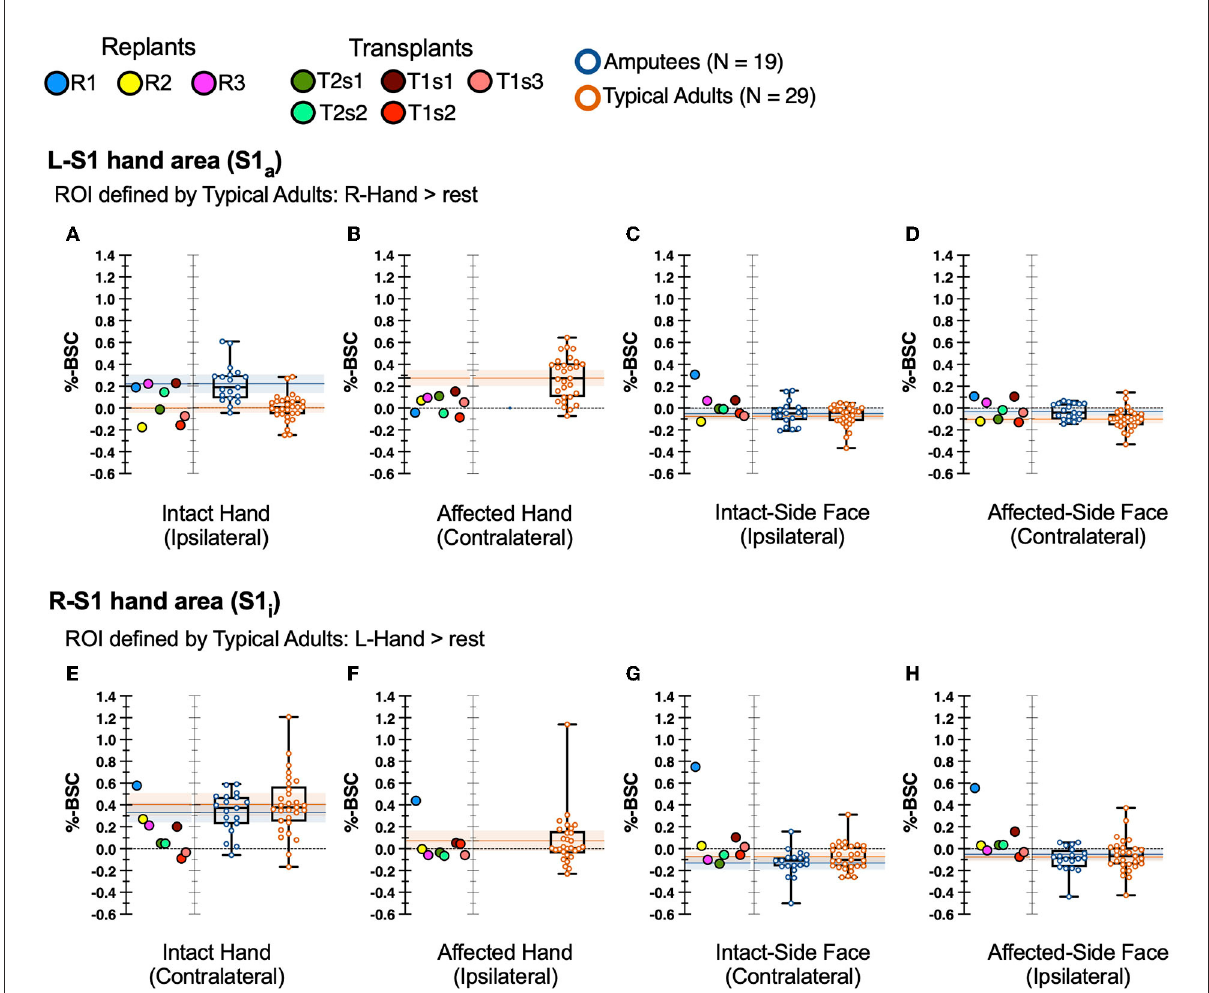
FIGURE3 fMRI activity in hand restoration patients and comparison groups. Single points represent transplants/replants. Boxplot lines at 25 th , 50 th , and 75 th percentiles. Shaded bars: 95% confidence interval of the mean of each comparison group. Top row (A–D) reflects S1 a ROI, bottom row (E–H) reflects S1 i ROI. First column (A,E) represents stimulation of the intact hand. Second column (B,F) represents stimulation of the affected hand. Third column (C,G) represents stimulation of the intact-side face. Fourth column (D,H) represents stimulation of the affected-side